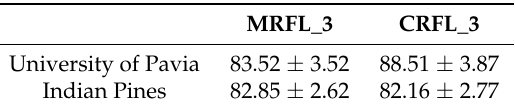
Table 5. Classification accuracies [%] based on the fusion of three sources (fractional abundances, probabilities based on spectra and probabilities based on morphological profiles) for the University of Pavia and Indian Pines